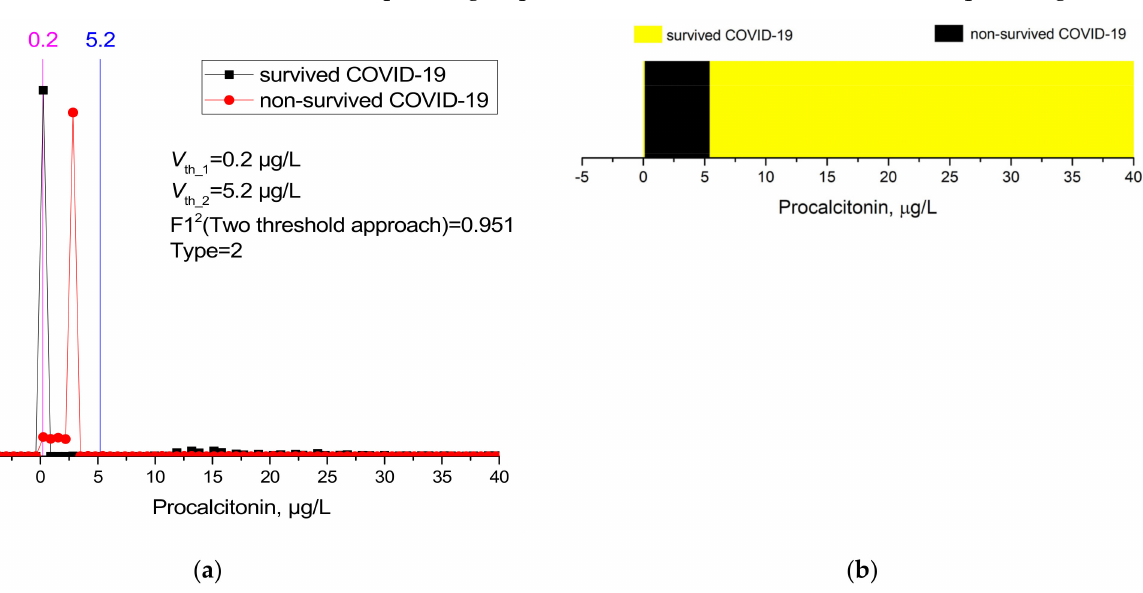
Figure 13. ( a ) Distribution of the procalcitonin feature in the original data of patients who survived and those who died from COVID-19, and the two-threshold value for this feature in classification. ( b ) The 1D masking technique for classifying patient-groups in the HGB model operated with the procalcitonin